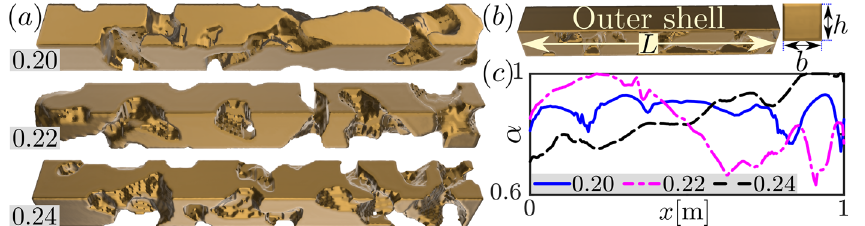
Fig. 2 Geometry of the different porous beams used for numerical simulations. a Porous cores with porosity p 0 ∈ {0.20, 0.22, 0.24}. b The beam is obtained by enclosing the porous core in a rectangular shell. c Spatial variation of the VO, α ( x ), across the length of the